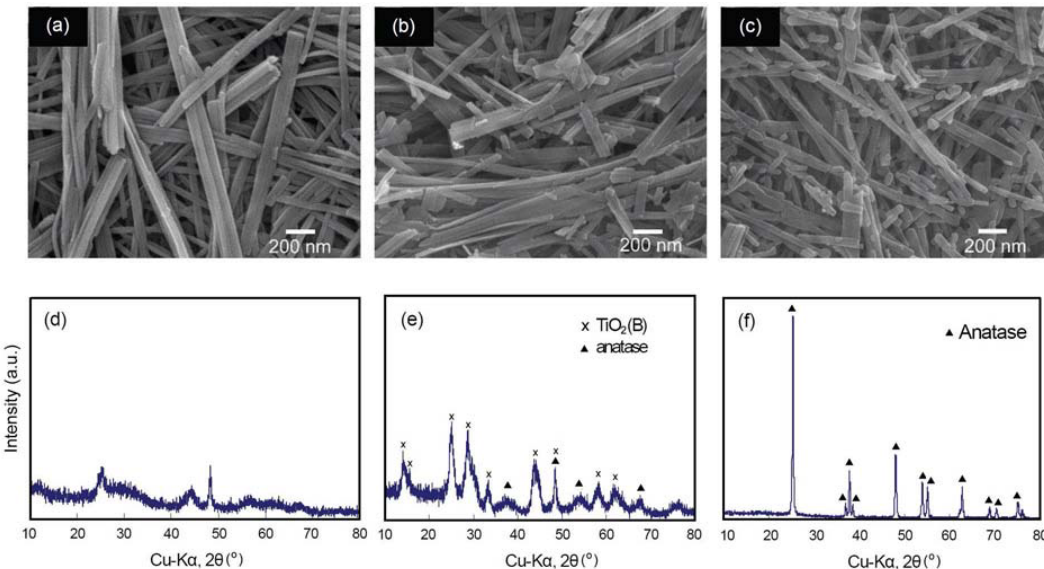
Fig. 3 SEM images and XRD patterns of TiO 2 nanowires by the hydrothermal method: (a,d) before calcination, hydrogen titanate, (b,e) after calcination at 400 ◦ for 2 h, TiO 2 (B) (this study), (c,f) after calcination at 700 ◦ for 2 h, TiO 2 anatase (after previos work